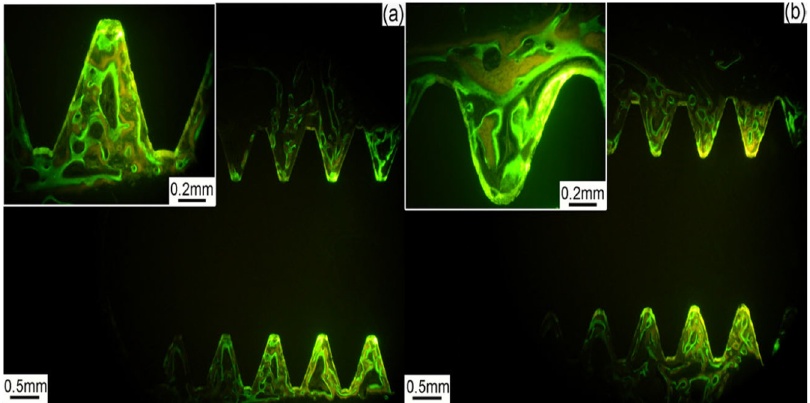
Figure 1. Histotomy of bone contact of: ( a ) CG Ti, and ( b ) NC Ti at four weeks, illustrated by fluorescence-dyeing reagents. Reprinted with permission from Ref. [25]. Copyright 2012, John Wiley and Sons.